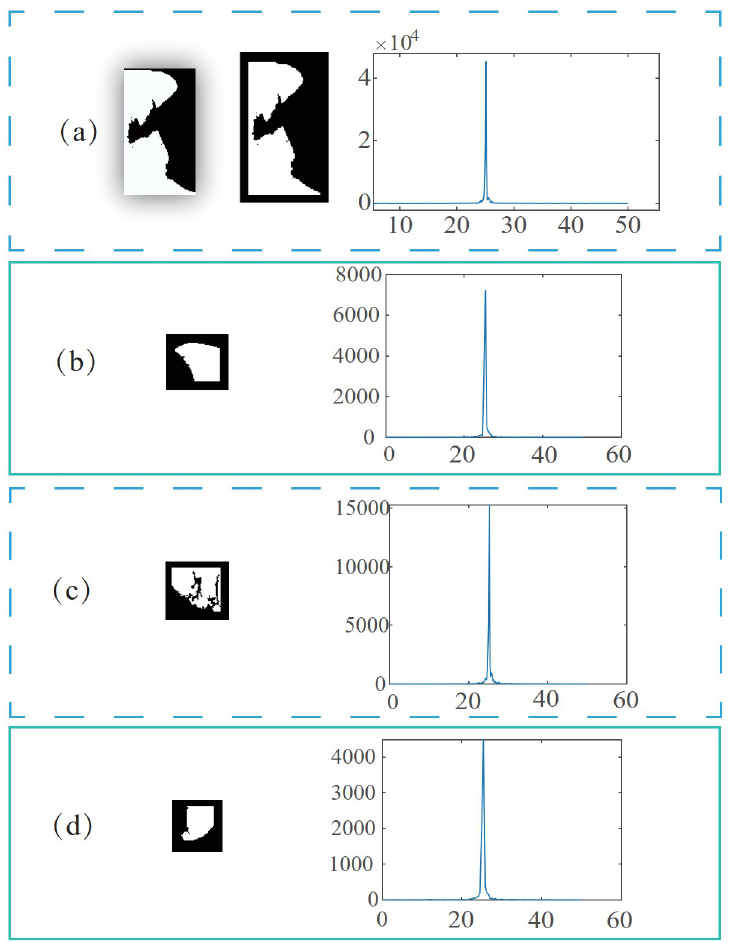
Fig 5. MERs and their Fourier descriptor figure. (a)-(d) show some local areas detected by the algorithm that need boundary repair and their Fourier descriptor